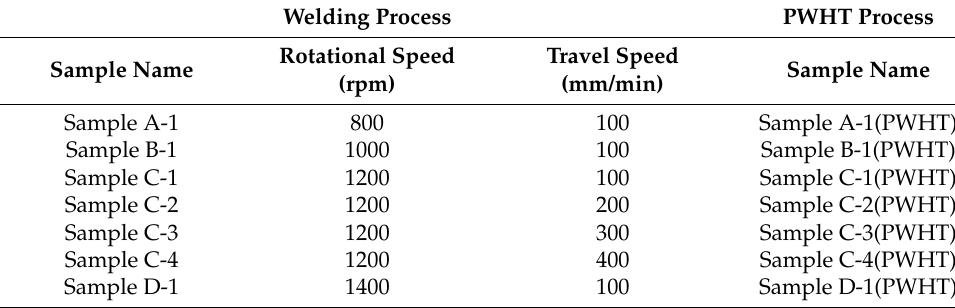
Table 2. Sample name and welding parameters of dissimilar joints of Al6061(T6)-Al5083.